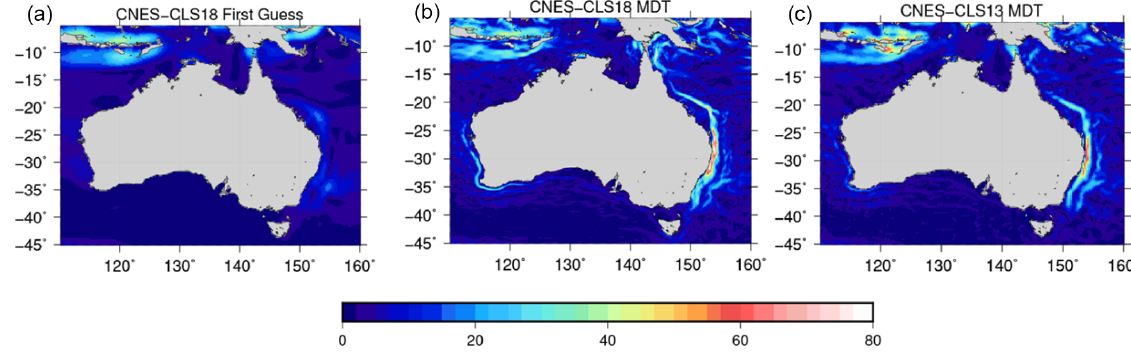
Figure 16. Mean geostrophic velocities around Australia in the CNES-CLS18 GOCE-based first guess (a) , in the CNES-CLS18 MDT (b) and in the CNES-CLS13 MDT (c)